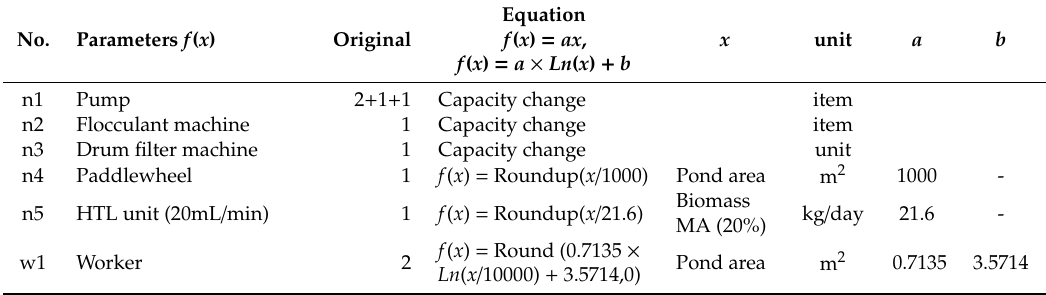
Table A3. Function list of “number of items and workers” for dependent parameters. ( x is derived from Table A1)